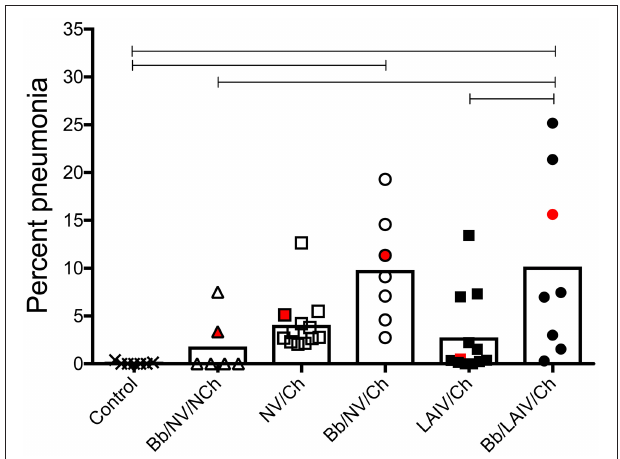
FIGURE 2 | Severity of pneumonia was associated with IAV challenge in B. bronchiseptica colonized pigs, regardless of LAIV vaccine status. Groups of pigs were inoculated with B. bronchiseptica (Bb) on day − 7, LAIV on days 0 and 21, and subsequently challenged (Ch) with heterologous IAV as described in materials and methods. A Non-vaccinated (NV) group and a NV/non-challenged (NV/NCh) control group were included as controls. At 5 days post-infection, the percentage of lung affected with macroscopic lesions was determined and reported as percent pneumonia, calculated as described in materials and methods. Each dot represents the score for a pig in that respective group, with averages indicated by bars. The red data point indicates the score and sample of lung section used for Figure 3 . Data was analyzed using a one-way ANOVA with a Tukey’s post-test (GraphPad Prism 6). Groups with connecting lines were significantly different ( p <